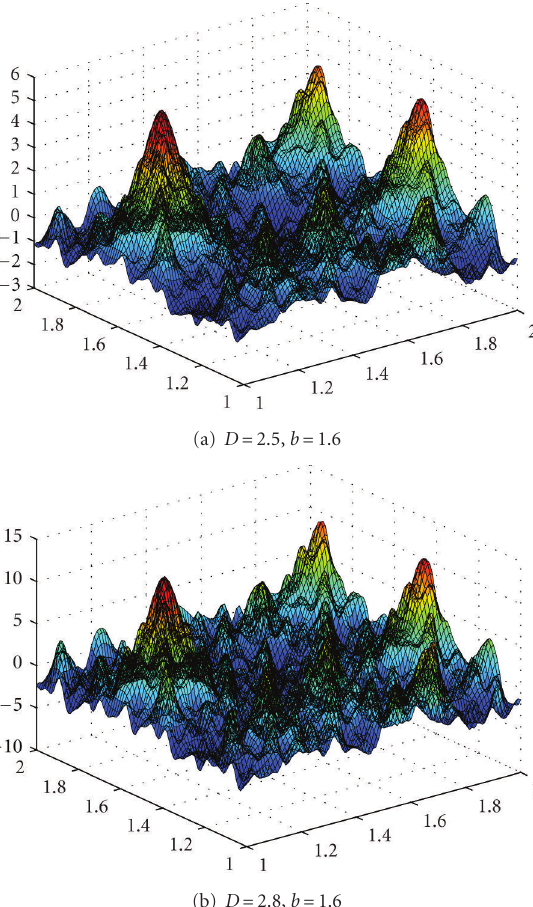
Figure 2: Two W-M surfaces produced using di ff erent fractal